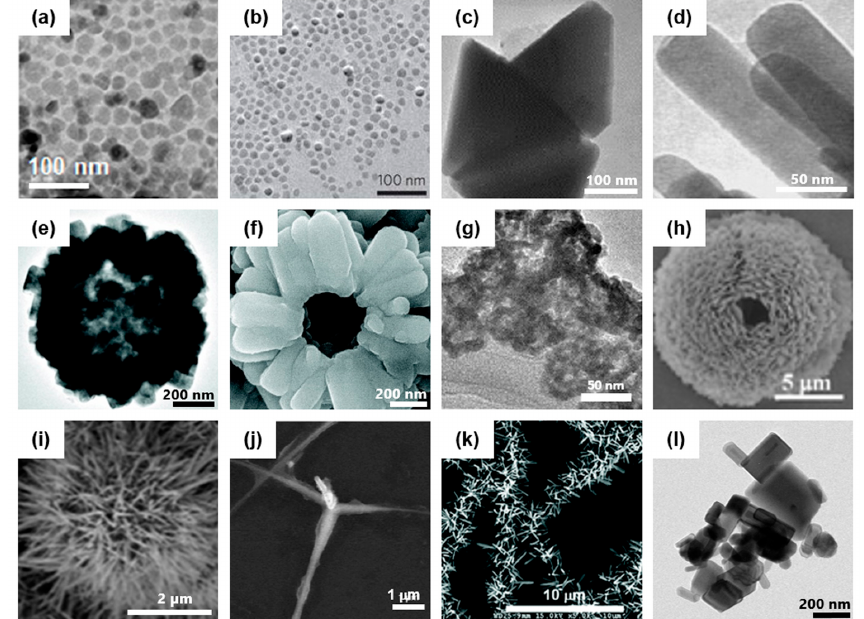
Figure 1. Artificially-synthesized ZnO-based nanocomposites with various sizes and shapes. ( a ) Transmission electron microscopic (TEM) image of ZnO NPs. Reproduced from Ha et al. [7] which is licensed under